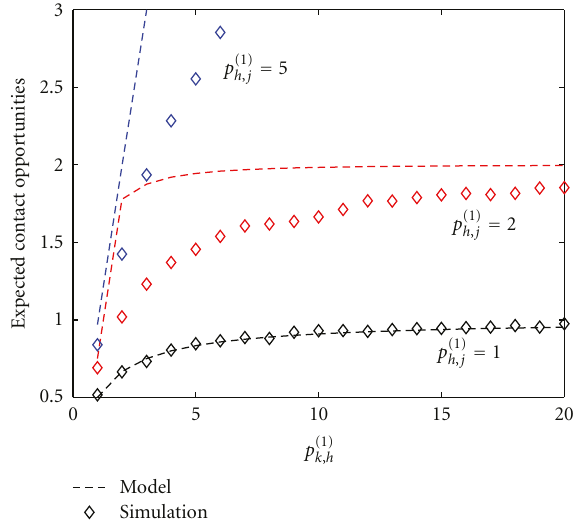
Figure 2: Comparison between model and simulation for the expected number of contact opportunities when p (1) k